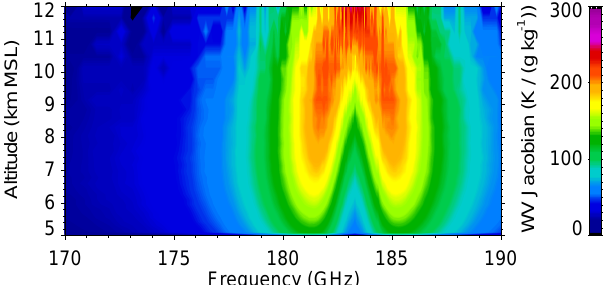
Figure 4. The water vapor Jacobian computed for mean conditions at Cerro Toco (surface altitude is 5.3kmm.s.l.) at the GVRP fre- quencies. The PWV for this case was